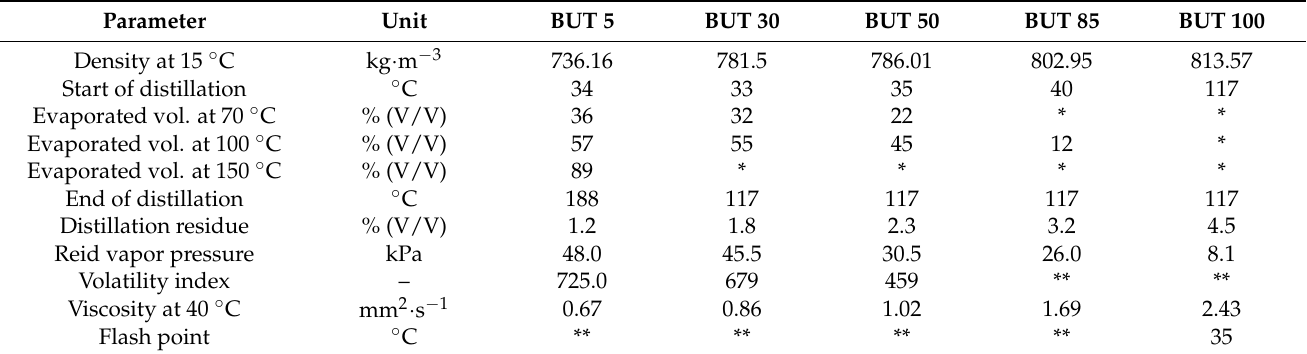
Table 2. Measured parameters of mixtures of n-butanol with